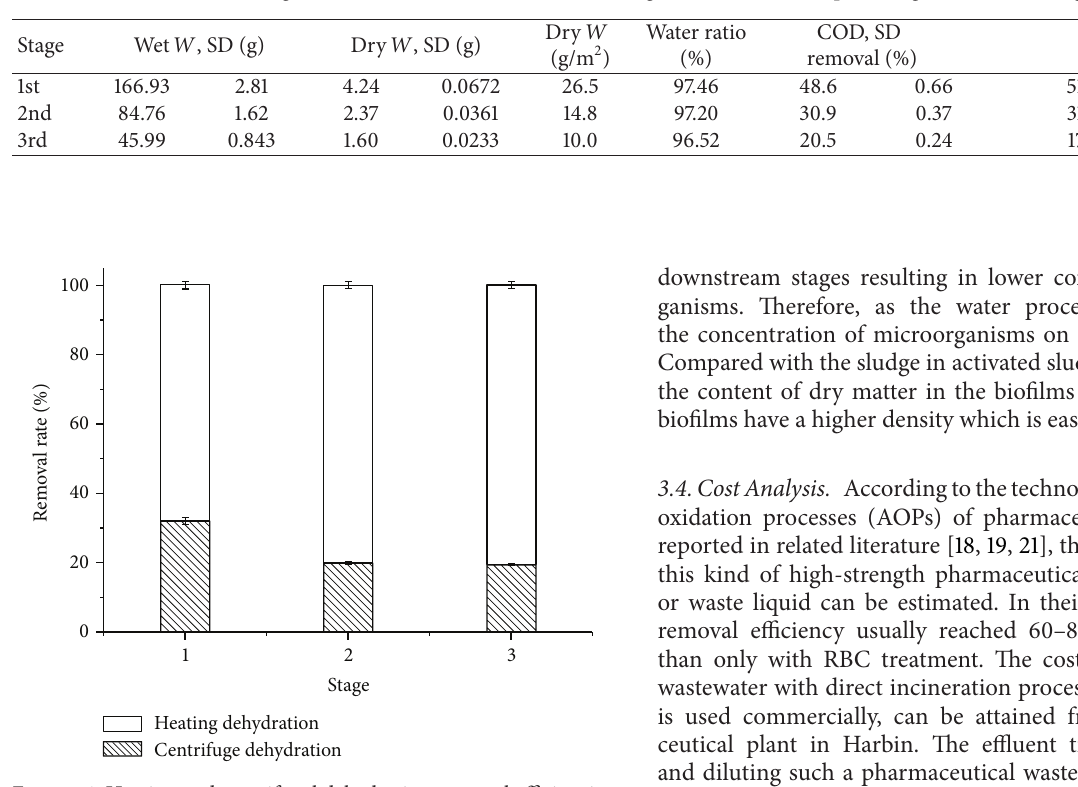
Figure 4: Heating and centrifugal dehydration removal efficiencies and standard deviations for each RBC